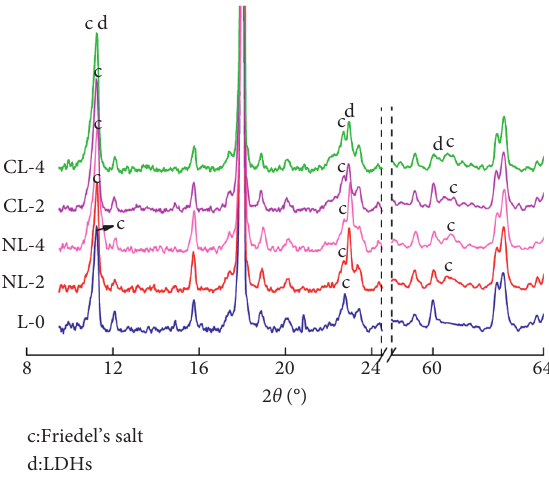
Figure 5: XRD local magnification of concrete with LDHs near 2 θ � 11.24 ° , 22.9 ° , and 60.5 ° .